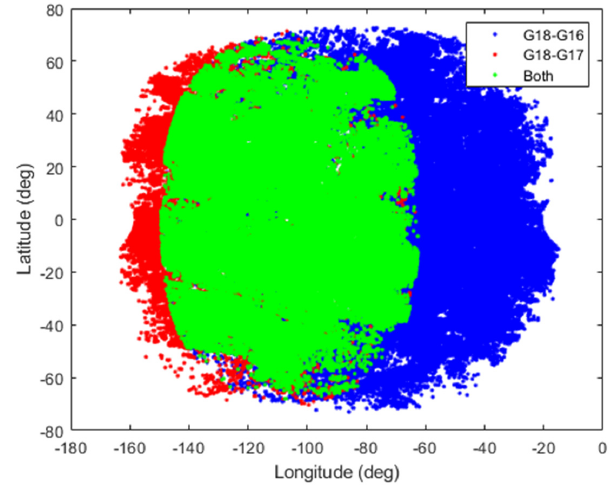
Figure 2. Sites for Stereo Wind Retrievals. Sites that are triple covered are shown in green.